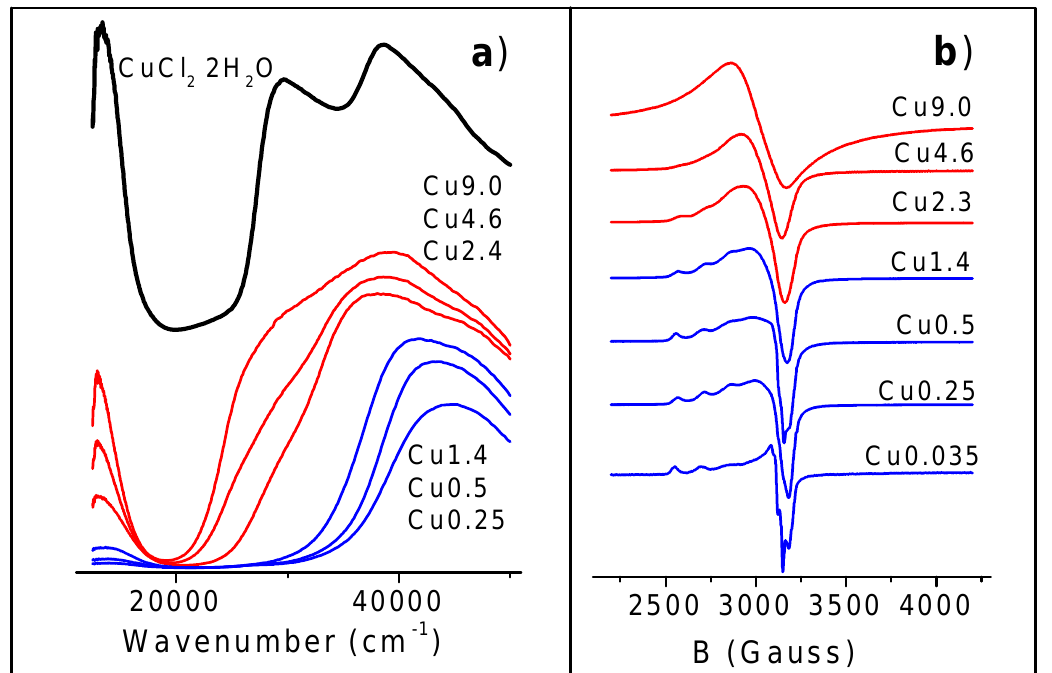
. H O (black), Cu9.0, Cu4.6, 2 2